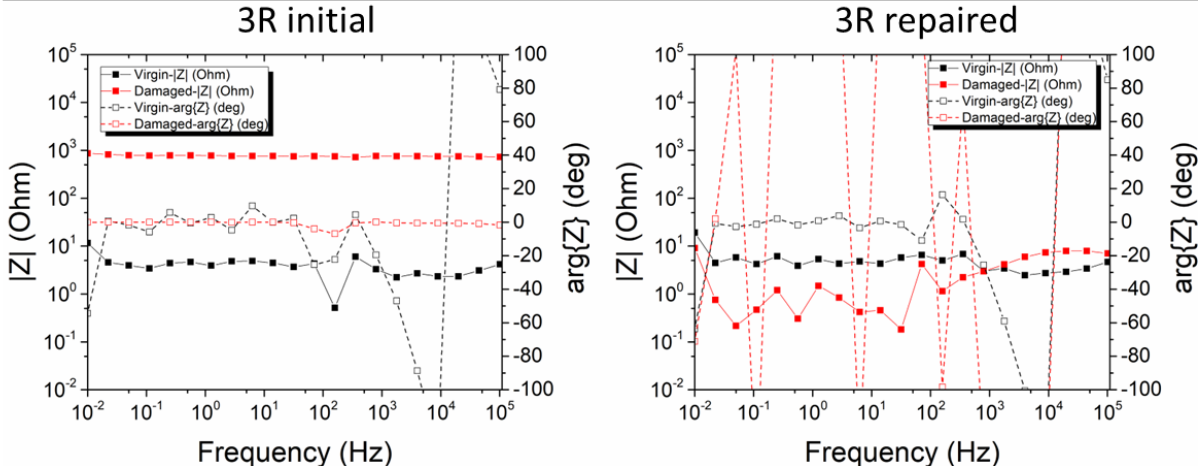
Figure 7. Impedance measurements of the 3R ILSS specimens before ( left ) and after ( right ) the repair process.